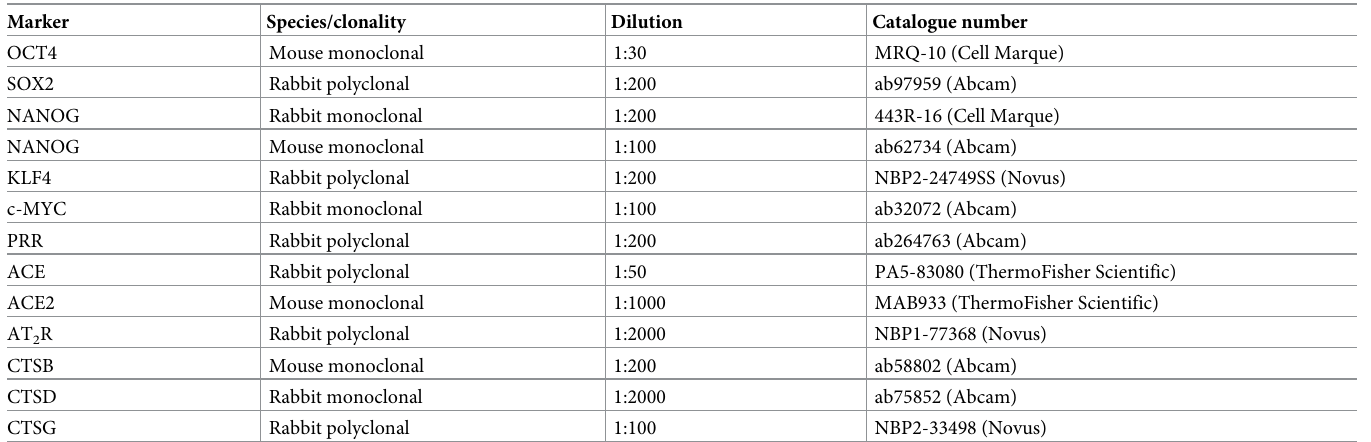
Table 1. Primary antibodies used for immunohistochemical and immunofluorescence staining.